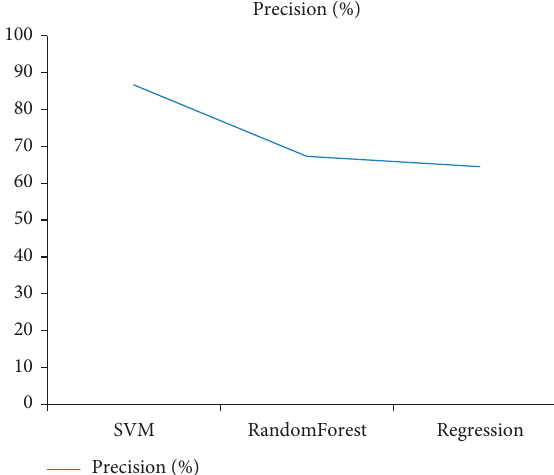
Figure 5: Precision of classifiers for intrusion classification for agriculture fields.